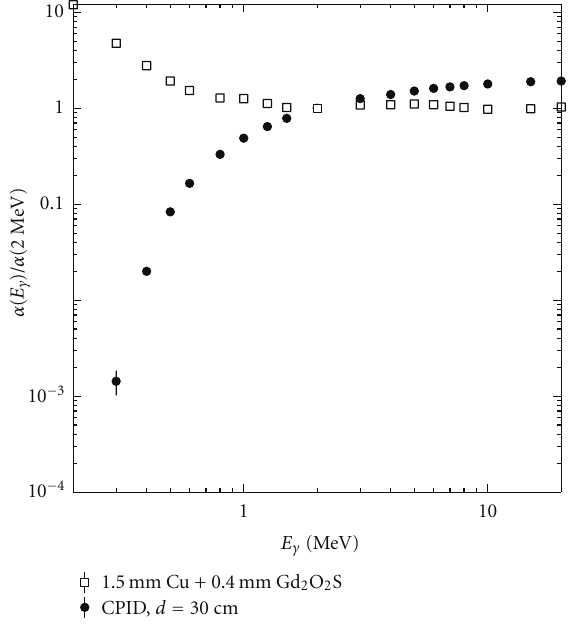
Figure 15: Energy dependence of the dose response (for a given dose to water) of a 30 cm thick CPID (solid circles) and that of a conventional Cu plate/phosphor screen system (open